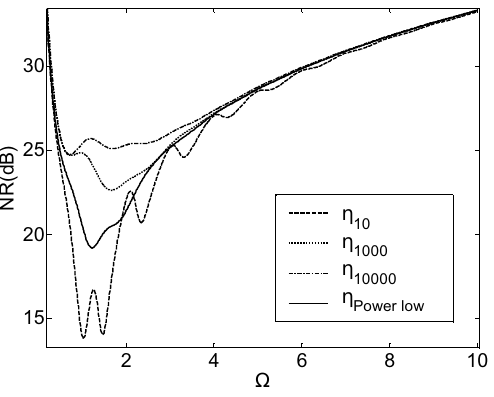
Fig. 6. Comparison between the noise reductions obtained from the constant and frequency dependent viscoelastic